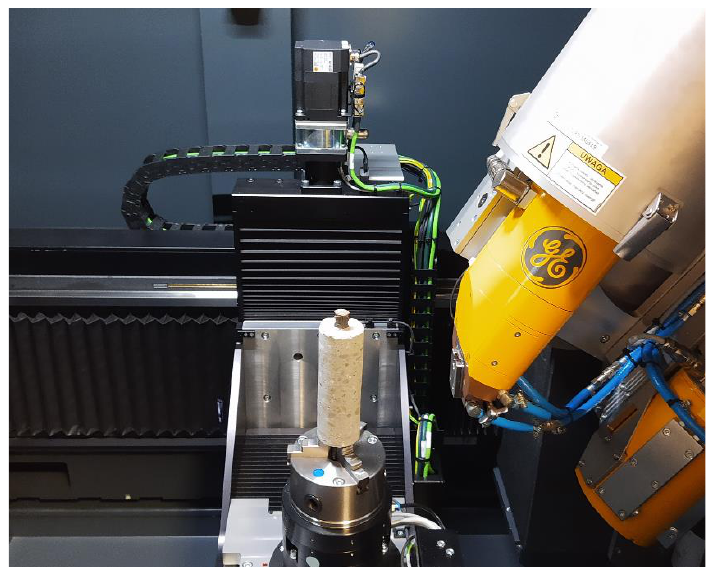
Figure 5. X-ray CT test set-up.